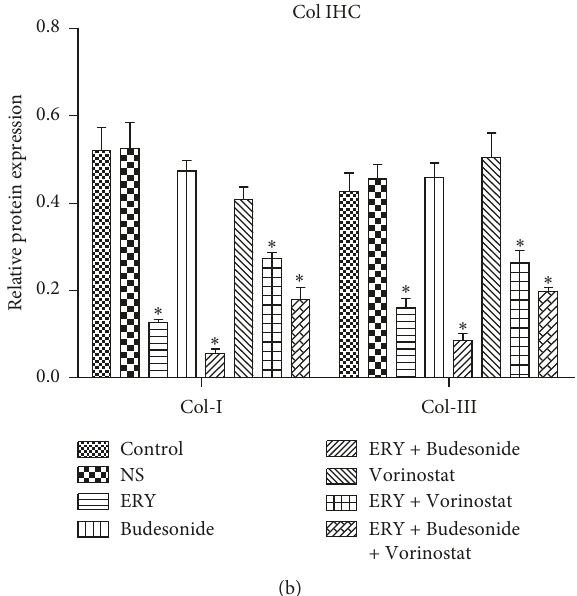
Figure 4: The expression of collagen I and collagen III in the different groups determined by immunohistochemistry. Image scale bar, 100 µ m. Brown staining, target protein collagen I and collagen III; blue staining, nucleus. Data are presented as the mean ± standard deviation in the corresponding histogram. ∗ P < 0 . 05 vs. the control group. Control: rabbit tracheal stenosis model without treatment; NS: rabbit tracheal stenosis model treated with penicillin; ERY: rabbit tracheal stenosis model treated with erythromycin; Budesonide: rabbit tracheal stenosis model treated with budesonide; Vorinostat: rabbit tracheal stenosis model treated with